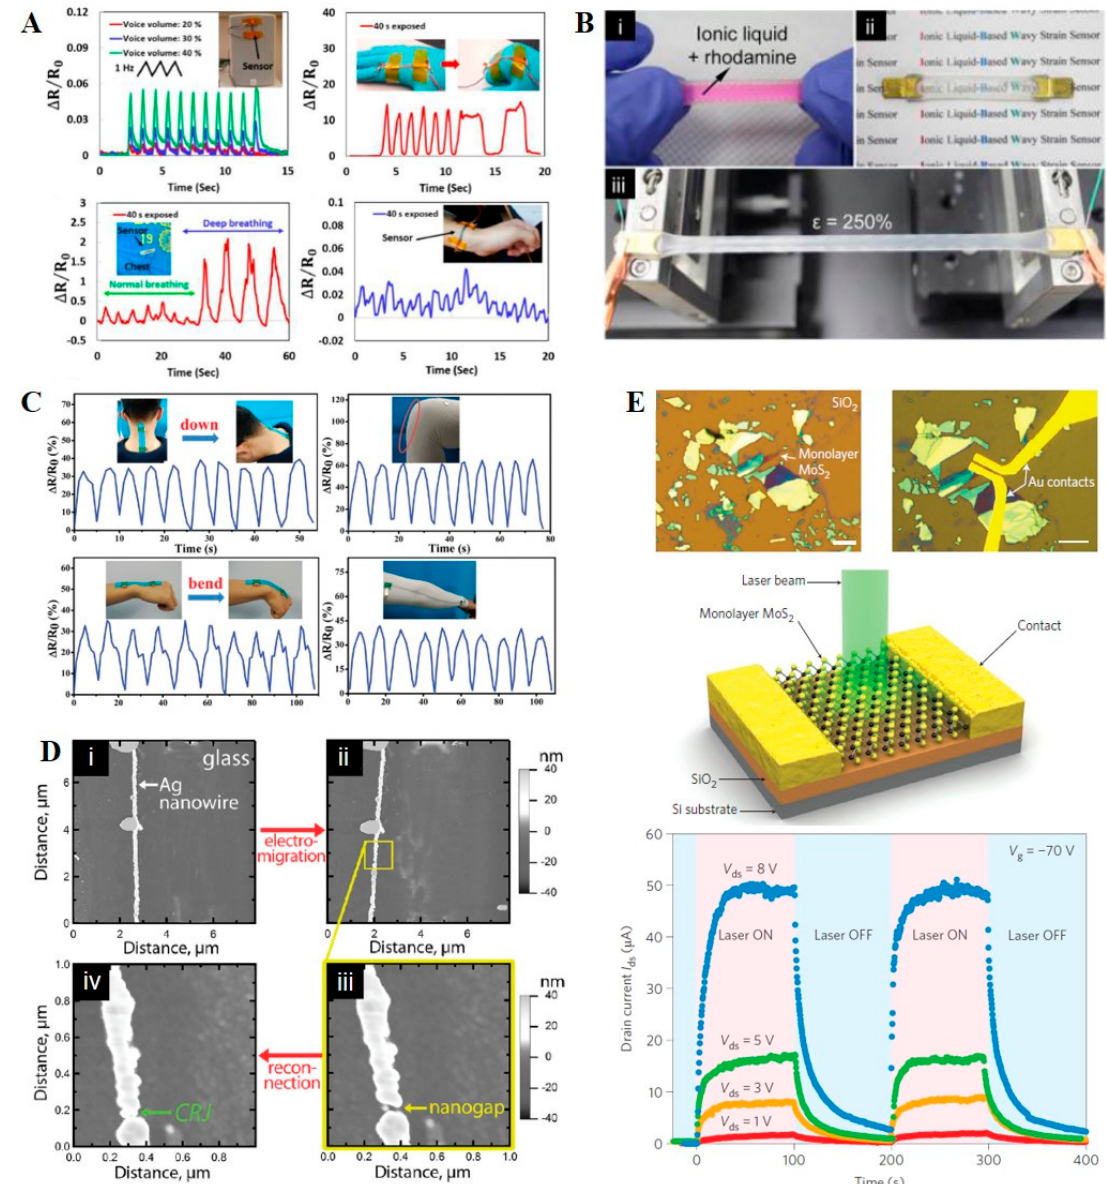
Figure 6. ( A ) Low-strain and large-strain application demonstrations of the proposed strain sensors. Reproduced with permission [98], copyright 2016, American Chemical Society. ( B ) Ionic-liquid-based wavy (ILBW) strain sensor, indicating its (i) wavy structure, (ii) good transparency, and (iii) super-stretchability. Reproduced with permission [99], copyright 2017, American Chemical Society. ( C ) Monitoring of human motion using the SWNT/multi-walled carbon nanotube